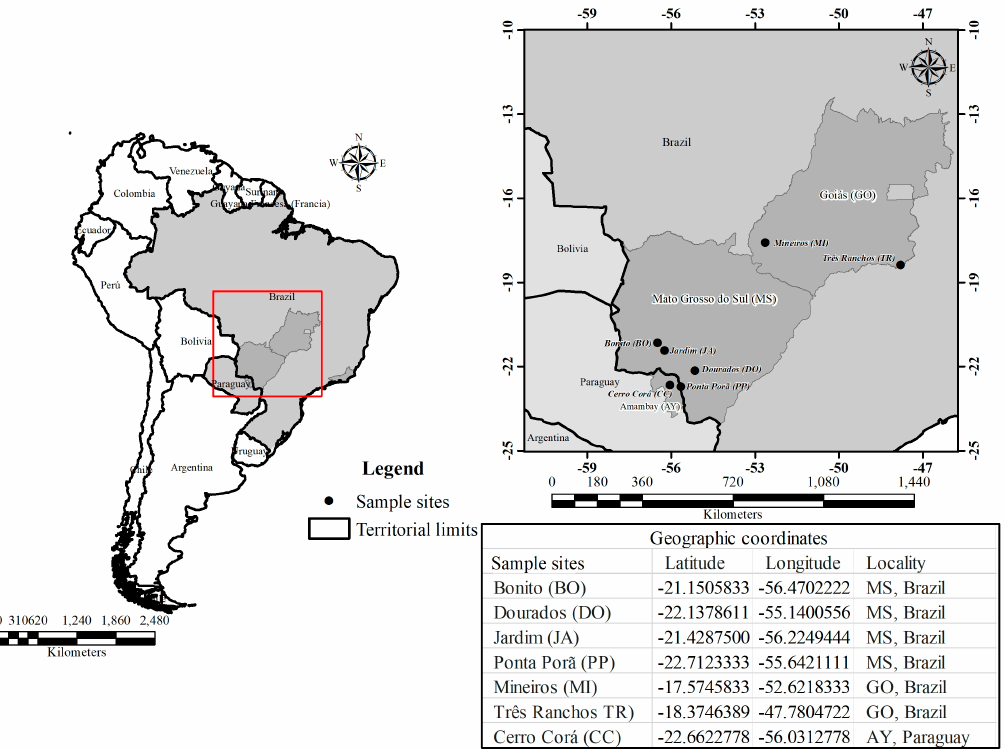
Figure 1. Map showing locations of the populations and the geographic coordinates at various Campomanesia adamantium sample sites.